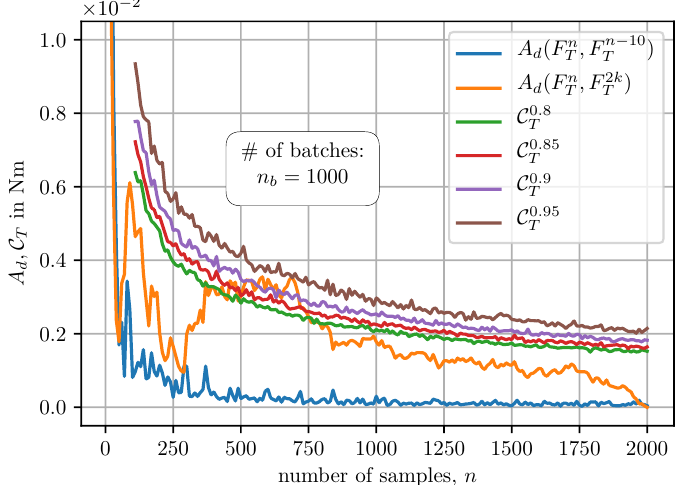
Figure 10. Confidence values over the number of available samples together with an evolution of absolute and relative deviation areas of F T (Figure 6).